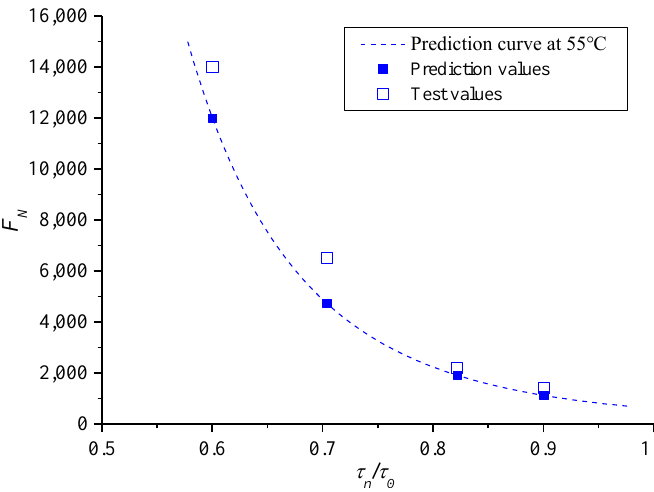
Figure 21. Comparison diagram of predicted and tested F N at 55 °C.